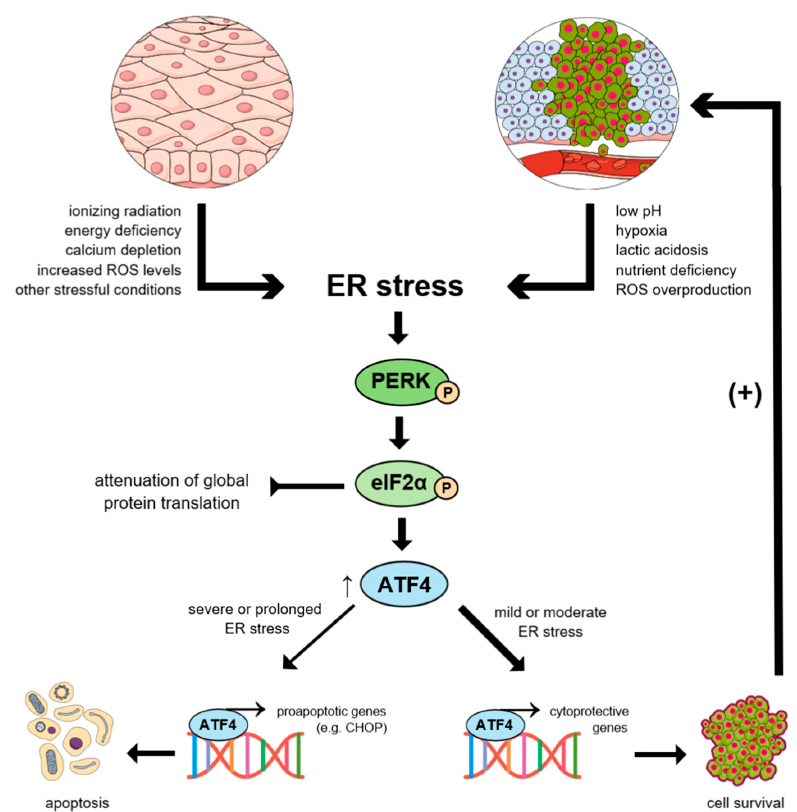
Figure 1. Dual response to Endoplasmic Reticulum (ER) stress conditions in normal epithelial cells and cancer cells via the protein kinase R (PKR)-like endoplasmic reticulum kinase (PERK)-dependent